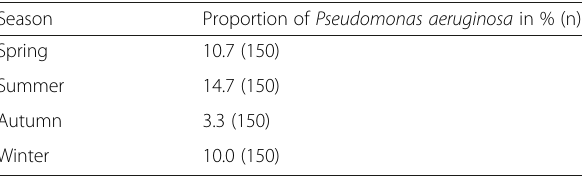
Table 2 Recovery frequencies of Pseudomonas aeruginosa from houseflies captured during different seasons in Shahrekord and Isfahan provinces of